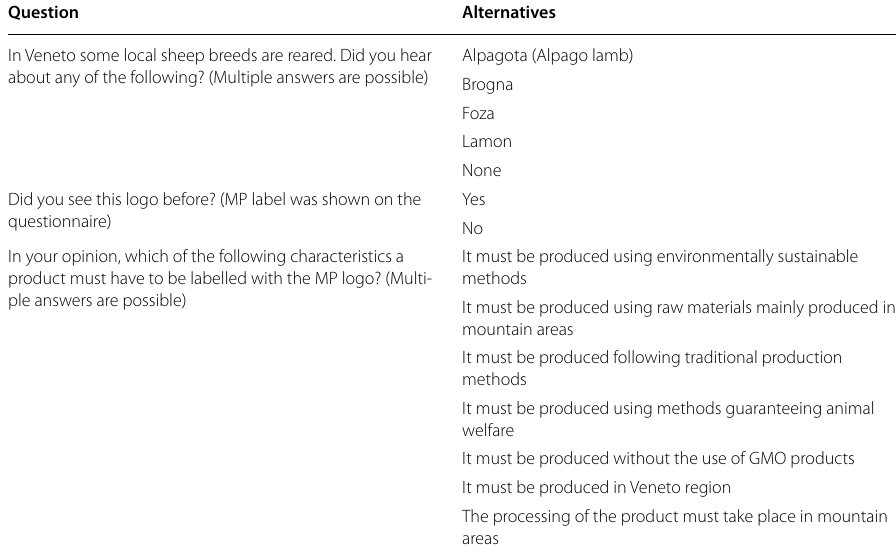
Table 10 Questions used to assess the knowledge of the local breeds and of the MP